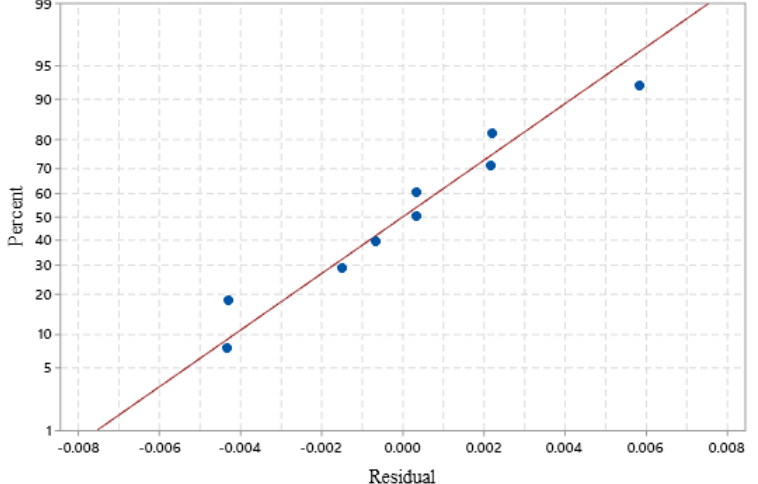
Fig. 4. Plot of normal